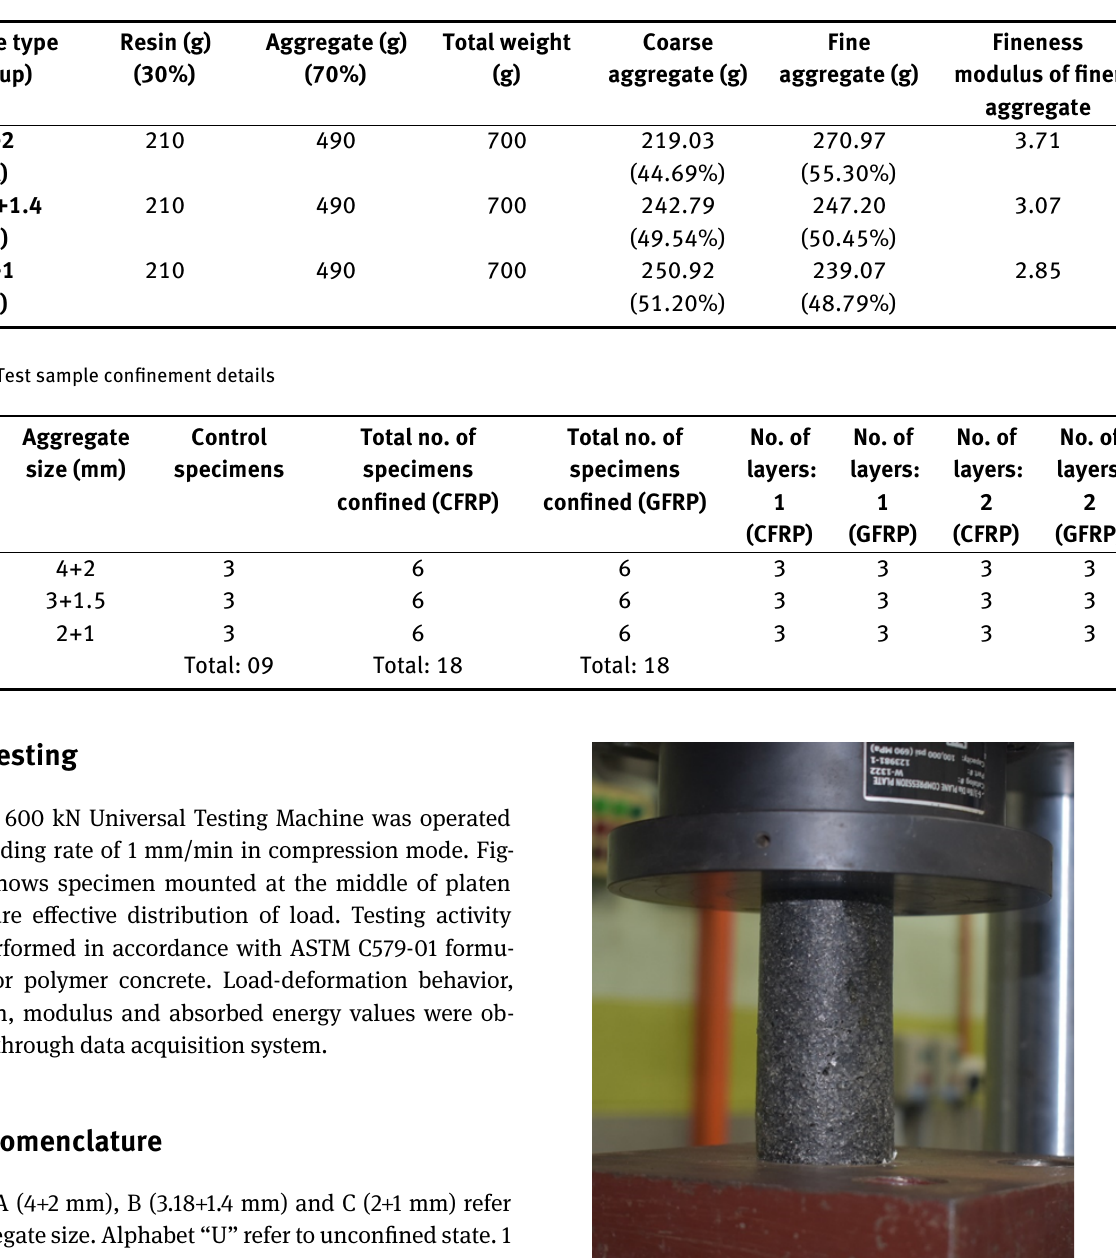
Table 3: Detailed sample mixture proportion plan